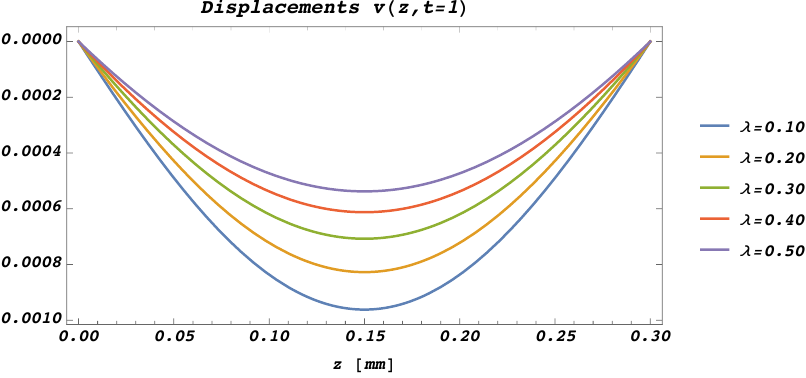
Figure 6. Vertical displcaments for different values of λ at t = 1 s. Whereas, the trends in the function of the nonlocal parameter for the other two kinematics entities are reported in Figure